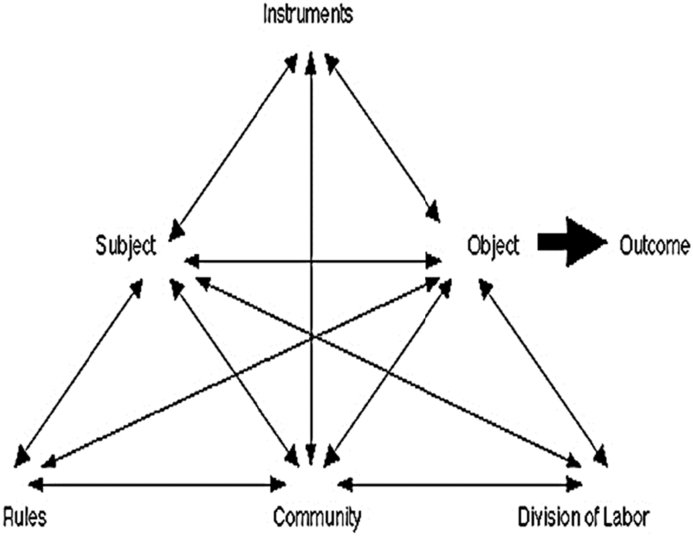
2nd Generation Activity Theory (Engestrom, 1999). Adapted under CC-by-SA-3.0, Bury (2012).